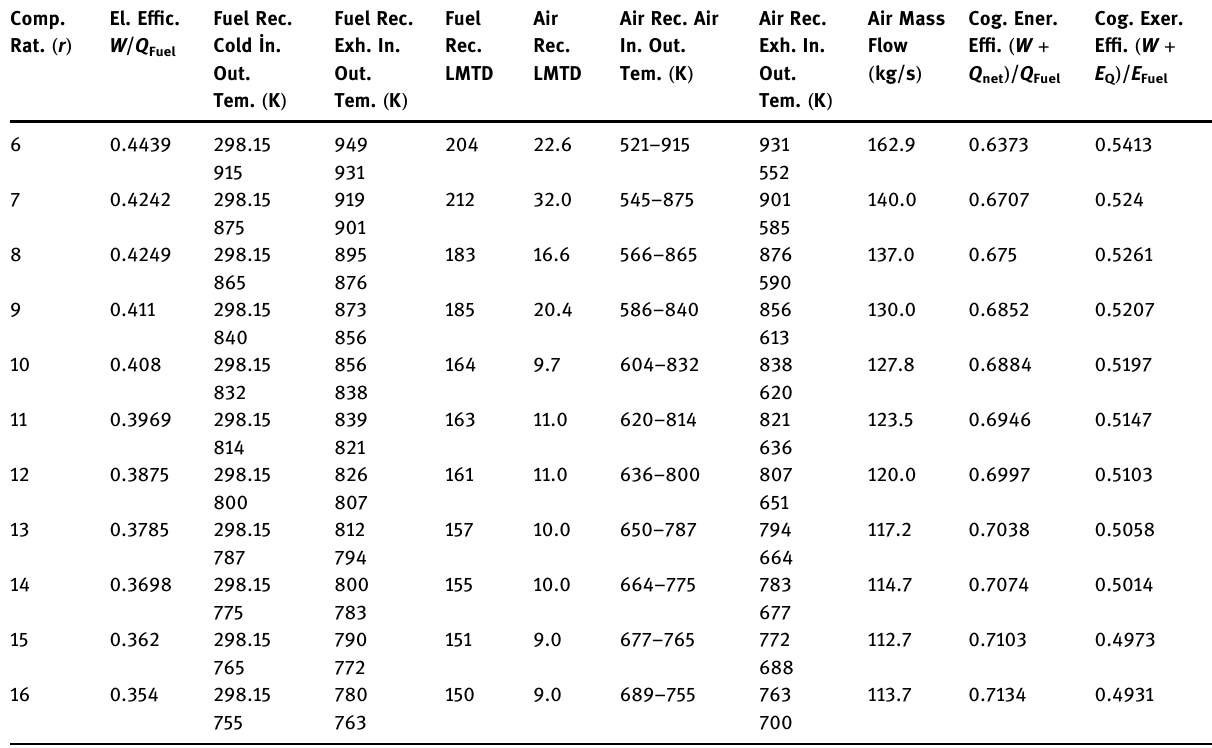
Table 3: Values of the air - fuel heating cycle obtained under the accepted conditions* for di ff erent compression ratios